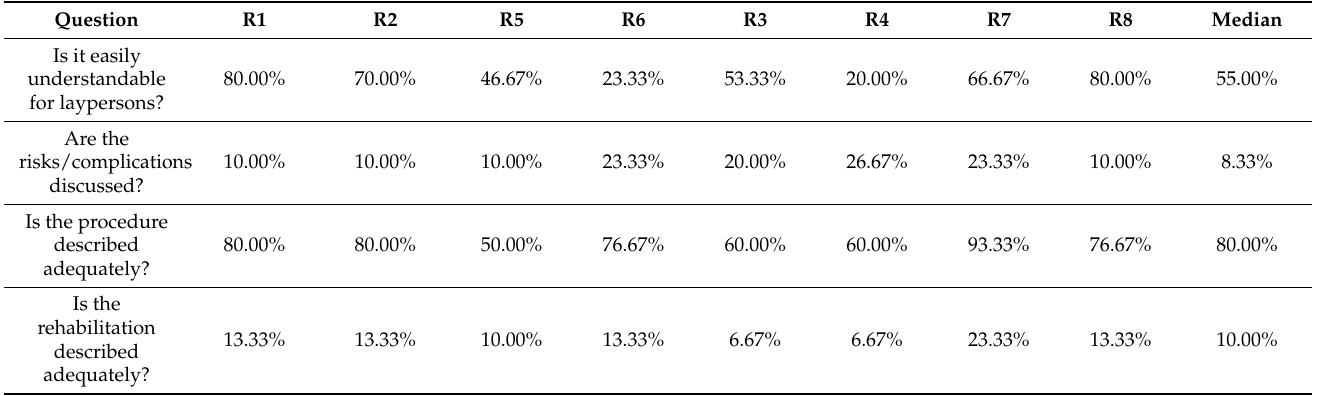
Table 2. Questions regarding quality/content and percent of videos that each rater assigned the answer “true”